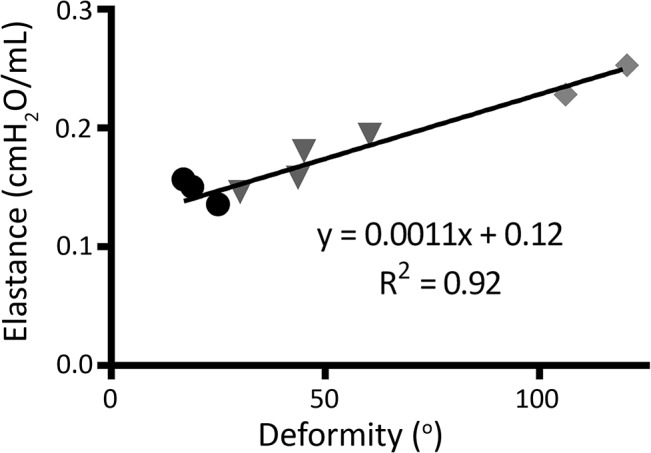
Respiratory elastance.Dynamic elastance versus spine deformity, θM. Normal rabbits are indicated by circles, Moderate deformity by triangles, and Severe deformity by diamonds.